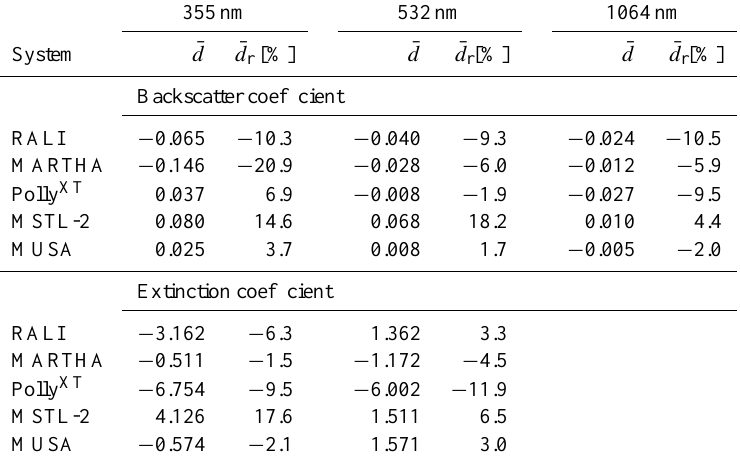
Table 1. Absolute ( ¯ d ) and relative ( ¯ d r ) mean deviations between SCC and corresponding manual analysis. The parameters ¯ d and ¯ d r are calculated according to the Eqs. (1) and (2), respectively, and considering all the profile altitude bins shown in Figs. 4–8. Backscatter coefficient absolute differences are expressed in Mm − 1 sr − 1 , while extinction coefficient absolute differences are given in Mm − 1